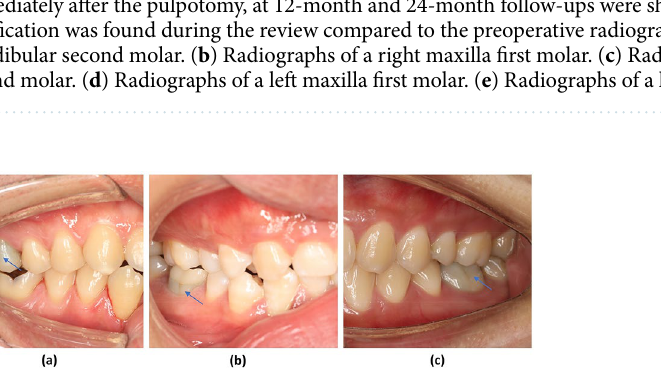
Figure 5. Tooth discoloration was observed at the 12-month follow-up on the teeth choosing different restoration methods after pulpotomy. ( a ) A right maxilla first molar with severe tooth wear was repaired by an inlay crown three months after pulpotomy, observed discolored at 12-month recall. ( b ) A right mandibular first molar with carious exposure was repaired by an inlay crown three months after pulpotomy and observed discolored at 12-month recall. ( c ) A left mandibular first molar with carious exposure, with a postoperative resin restoration, was observed discolored at 12-month